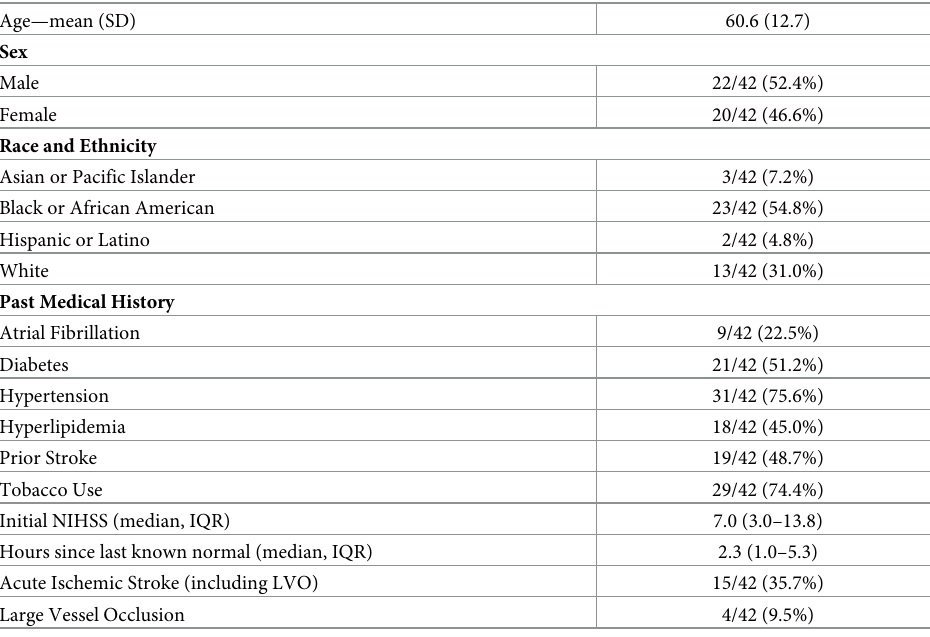
Table 2. Characteristics of patients transferred during the protocol.